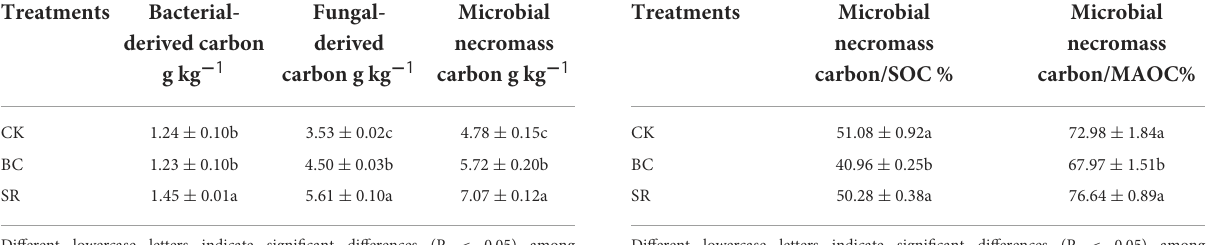
TABLE 4 Effect of straw and straw biochar on soil microbial necromass carbon contents. Treatments